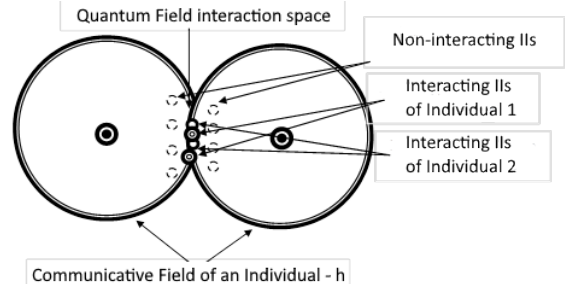
Fig. 1. Interaction of communicative fields of two individuals The interaction function for these two individuals or an individual a nd t he e xternal a ction should b e written